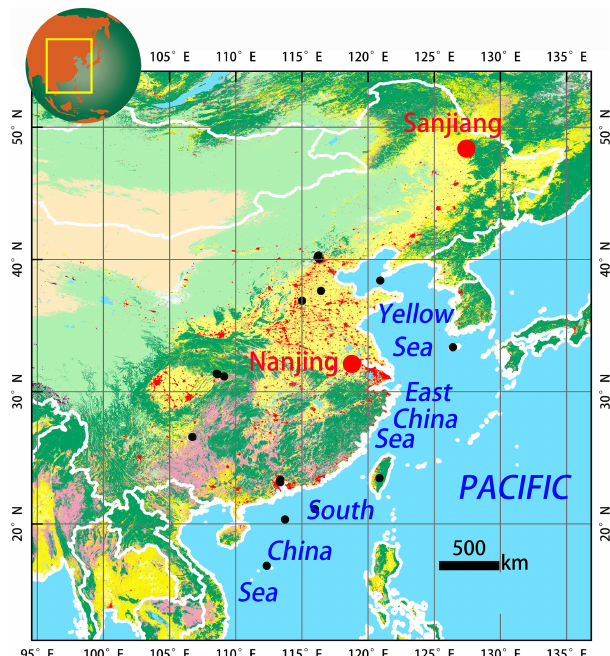
Figure 1. Location of the sampling sites Sanjiang and Nanjing. The black dots indicate the location of sampling sites (sites are located in the area of mainland China and the Yellow, East China and South China seas) with δ 15 N–NO − data from the literature (see also Ta- 3 ble